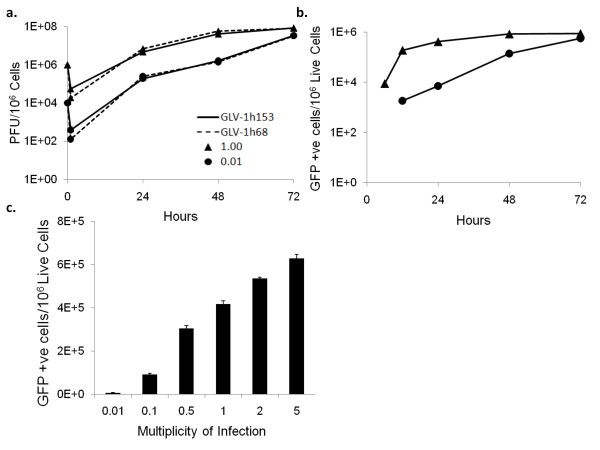
Viral proliferation assay of GLV-1h153-in PANC-1 cells. a. PANC-1 cells were grown in 6-well plates and infected with GLV-1h153 or GLV-1h68 at an MOI of 0.01 and 1.0. Three wells of each virus were harvested at 1, 24, 48, and 72 hours postinfection. GLV-1h153 replicated in a similar manner to GLV-1h68, with a 4-log increase in viral load at an MOI of 0.01 by 72 hours, reaching similar levels as that in cells infected with an MOI of 1.0. This demonstrates that GLV-1h153 is able to replicate efficiently within PANC-1 cells in vitro as well as parental virus GLV-1h68. b. GFP expression was quantified via flow cytometry in PANC-1 cells infected with GLV-1h153 at MOIs of 1.0 and 0.01 and was shown to be MOI dependent. GFP expression mimicked the viral replication growth curve, with GFP expression in the MOI 0.01 infected cells reaching similar levels as the MOI of 1.0 by 72 hours after infection. c. GFP expression was quantified via flow cytometry in PANC-1 cells infected with an MOI of 0.01, 0.1, 0.5, 1.0 2.0, and 5.0 at 24 hours after infection, and was shown to be MOI-dependent.